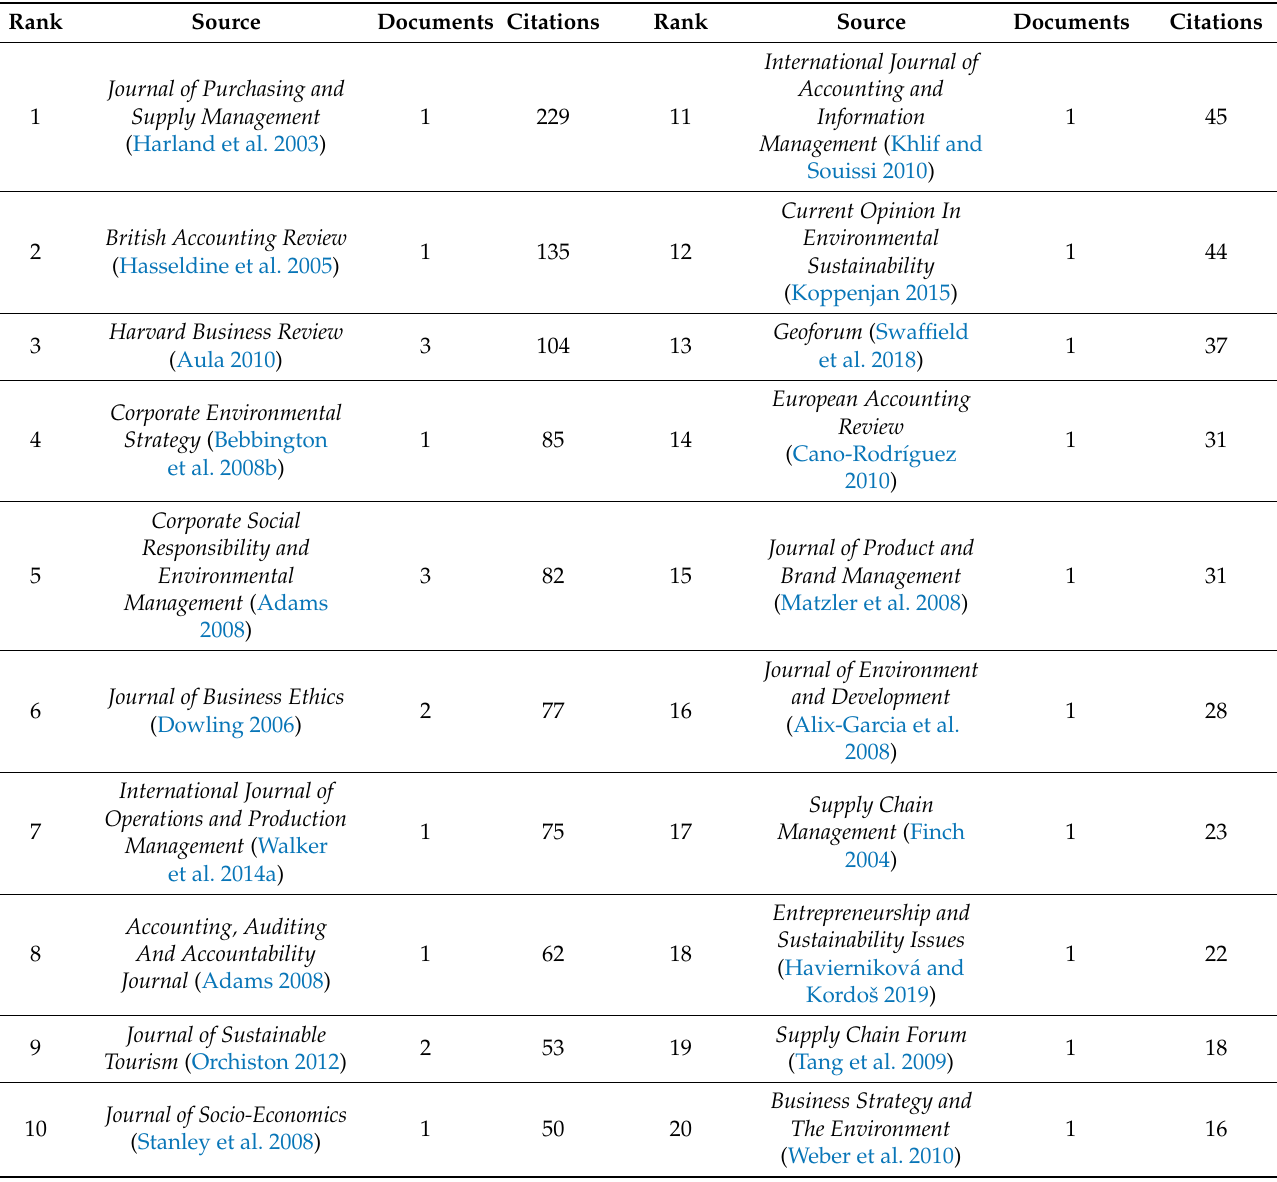
Table 2. Sources of searched